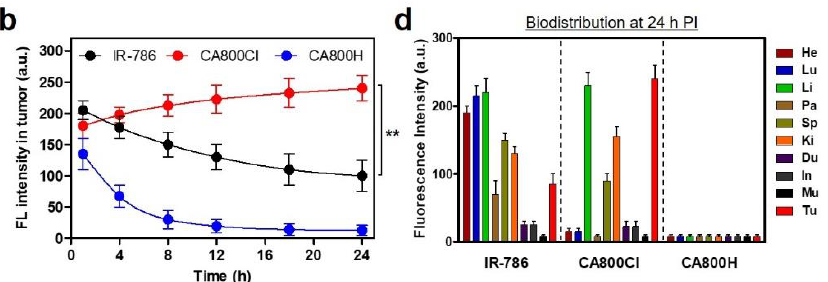
Figure 4. In vivo NCI-H460 tumor targeting efficiency and biodistribution of NIR fluorophores. ( a ) NIR fluorescence imaging at 1 h, 4 h, and 24 h post-injection of IR-786, CA800Cl, and CA800H, respectively. ( b ) Time-dependent fluorescence intensities at the tumor sites targeted by each NIR fluorophore. ( c ) Resected organs and tumors imaged 24 h after injection of each NIR fluorophore. ( d ) Quantitative fluorescence analysis of intraoperative dissected organs 24 h post-injection of each NIR fluorophore. The tumor site is indicated by an arrowhead. Abbreviations: Du, duodenum; He, heart; In, intestine; Ki, kidneys; Li, liver; Lu, lungs; Mu, muscle; Pa, pancreas; Sp, spleen; Tu, tumor; and PI, post-injection. Scale bars = 1 cm. All NIR fluorescence images have identical exposures and normalizations. Data are expressed as mean ± S.D. (n = 3). ** p < 0.01.